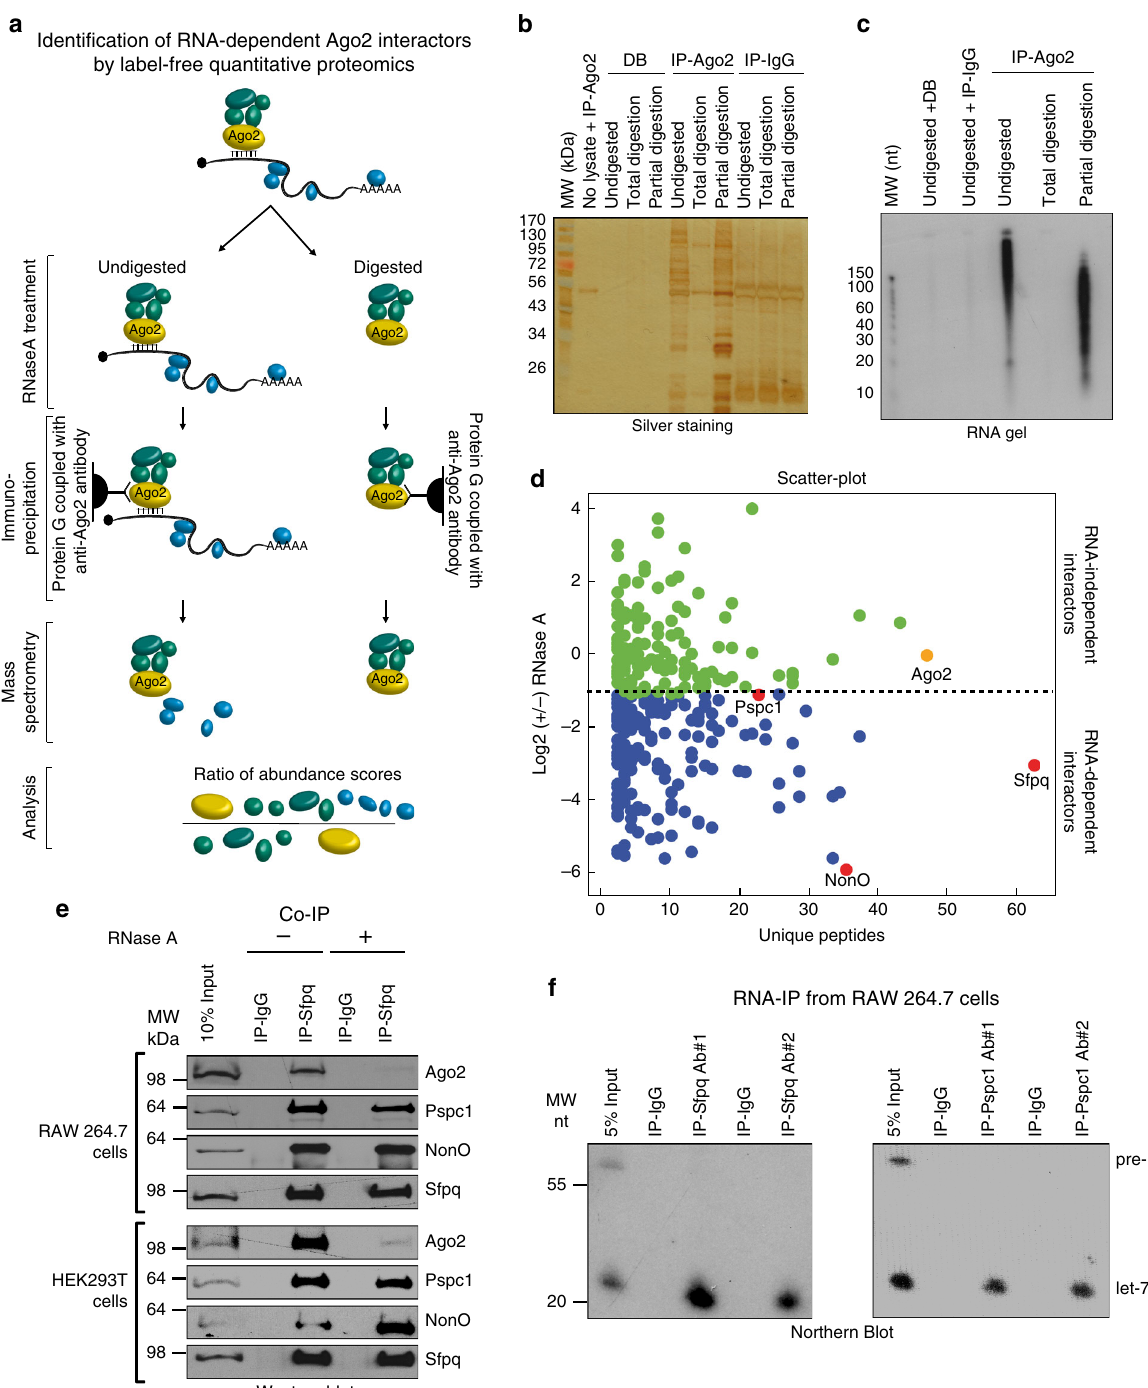
Fig. 1 Sfpq, Pspc1, and NonO are components of Ago2 complex and interact with let-7a. a Overview of the proteomic method used to identify RNA- dependent proteins interacting with Ago2. b Silver staining of an SDS-PAGE analysis from the IP with the anti-Ago2 antibody, the protein G conjugated with the Dynabeads (DB), or the anti-Ago2 antibody alone incubated without cell lysate. The samples were untreated, treated with 10 μ g ml − 1 RNase A for 30 min at room temperature (for partial digestion), or treated with 10 mg ml − 1 RNase A for 30 min at room temperature (for total digestion). c Radioactive images of a TBE-Urea gel showing signal from 32 P-labeled RNA fragments of samples untreated, treated with 10 μ g ml − 1 RNase A for 30 min at room temperature (for partial digestion), or treated with 10 mg ml − 1 RNase A for 30 min at room temperature (for total digestion). d Scatter-plot of the log base 2 ( − /+) RNase A ratios (abundance scores) plotted with the unique peptides for each identi fi ed protein. Each spot is a different protein. e Co-IP of endogenous Sfpq and Ago2, Pspc1, or NonO in RAW 264.7 and HEK293T cells. When indicated, cell lysates were incubated at room temperature with RNase A (10 mg ml − 1 ) for 30 min. f Sfpq and Pspc1 interact with mature let-7a but not with the precursor. RAW 264.7 cell extracts were immunoprecipitated with two different antibodies for each indicated protein. The RNA was puri fi ed and analyzed by Northern